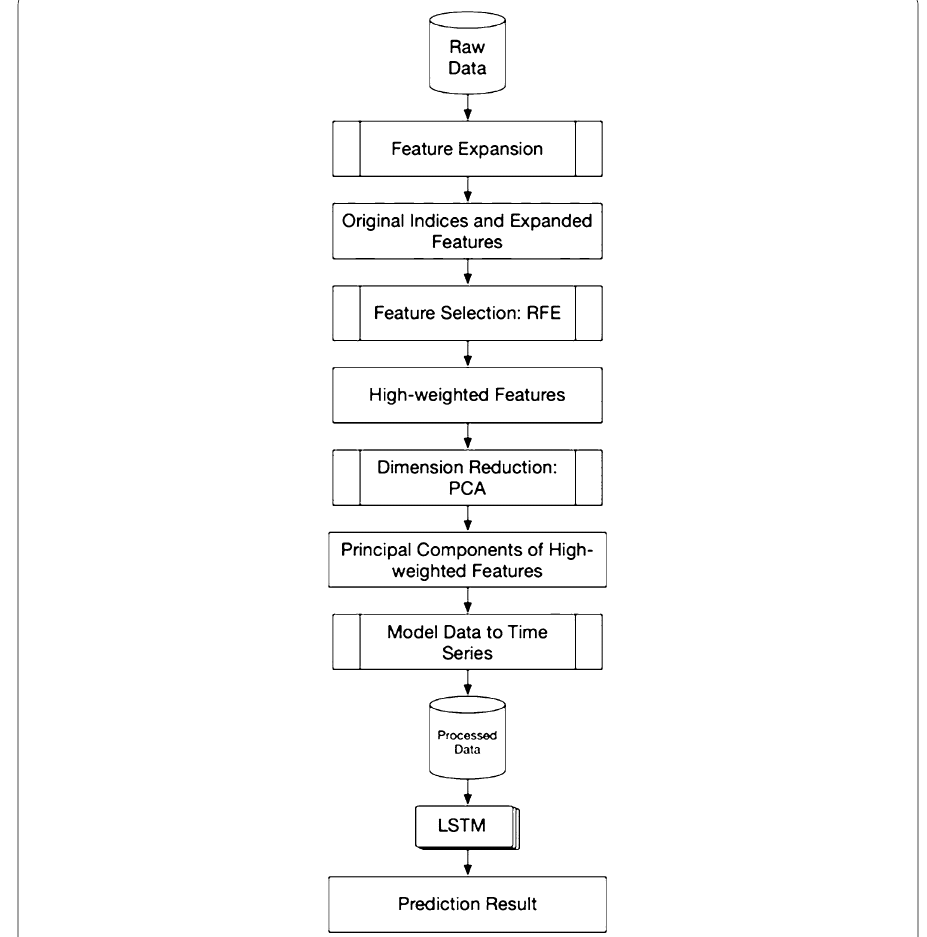
Fig. 2 High-level architecture of the proposed